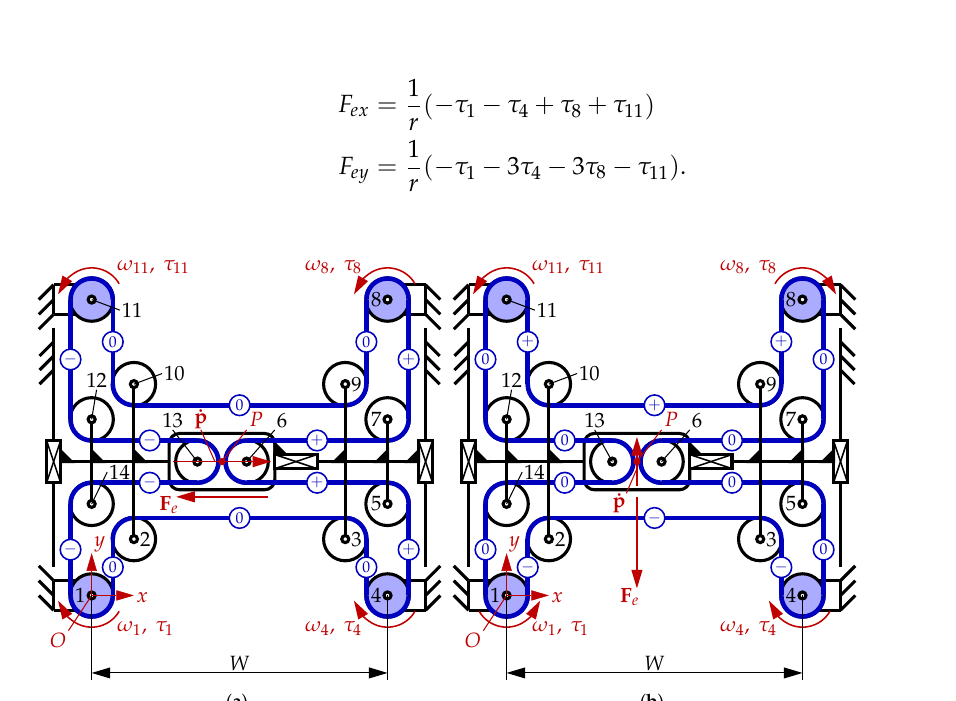
Figure 9. (a) : force distribution in the CoreH-bot, as the print head moves along the + x direction. (b) : same, for the + y direction. The torques τ i and angular speeds ω i of the motors are also shown.